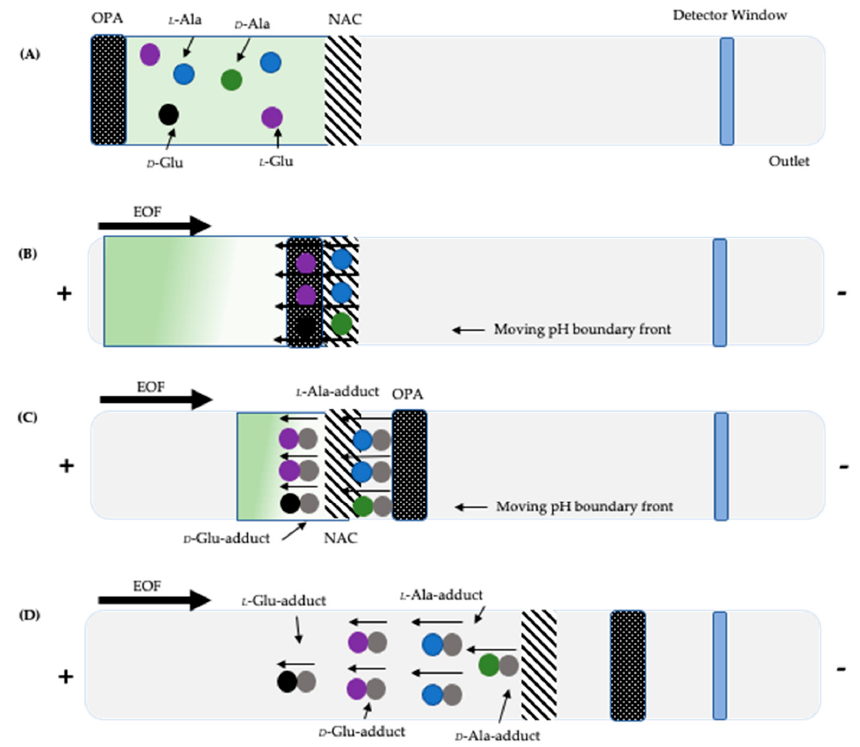
Figure 1. General scheme of SPDE-CE for chiral amino acids separation. ( A ) multiple hydrodynamic injection sequence; ( B ) on-line sample pre-concentration by dynamic pH junction and transient isotachophoresis; ( C ) in-capillary chemical labeling by zone passing of OPA/NAC; ( D ) chiral separation of diastereomeric amino acid adducts enantioselectivity by SPCD–CE. Adapted from [81].